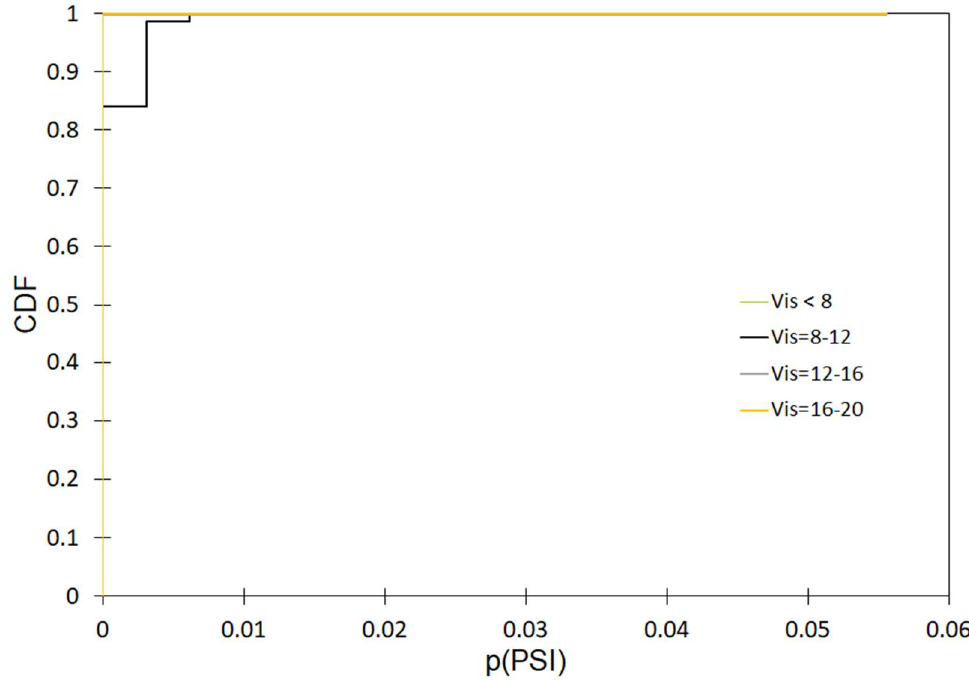
Figure A35. Effect of visibility on the incidence of very high spring mortality for dry days.